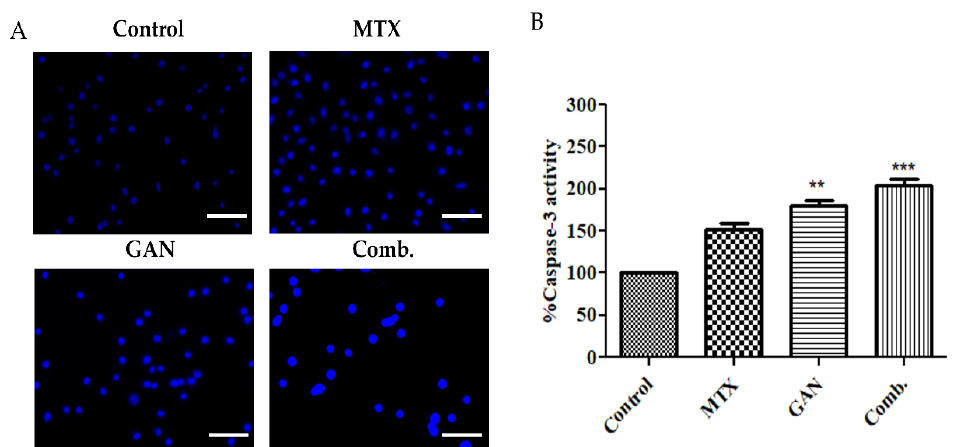
Figure 3. ( A ) Efficacy of individual and combined doses of GAN and MTX in inducing nuclear condensation and fragmentation in A549 cells compared to untreated control as analyzed with DAPI staining. Scale bar = 100 µm, Magnification: 20×. ( B ) Percent (%) caspase-3 activity in A549 cells after treatment with individual and combined GAN/MTX doses compared to untreated control. ** p < 0.01 and *** p < 0.001.